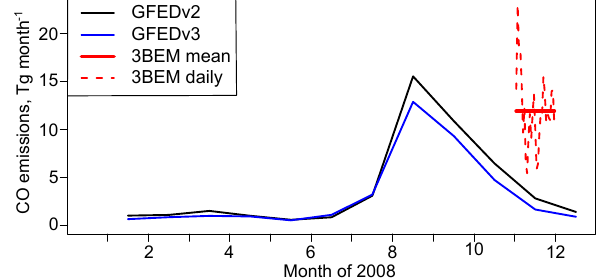
Fig. 14. Biomass burning CO emissions integrated over the STILT model domain covering most of South America (see bottom of Fig. 2) from different emission models in Tgmonth − 1 during 2008. GFEDv2: black line, GFEDv3: blue line, 3BEM: red line, 3BEM daily fluxes: red dashed